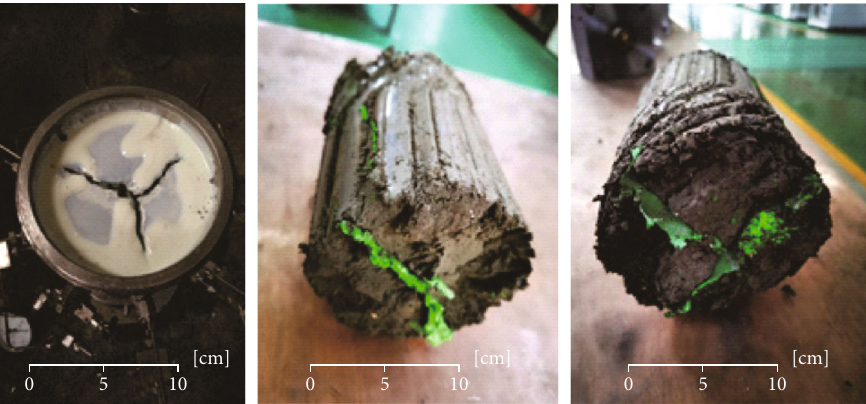
Figure 7: The fracture morphology in clayey-silt